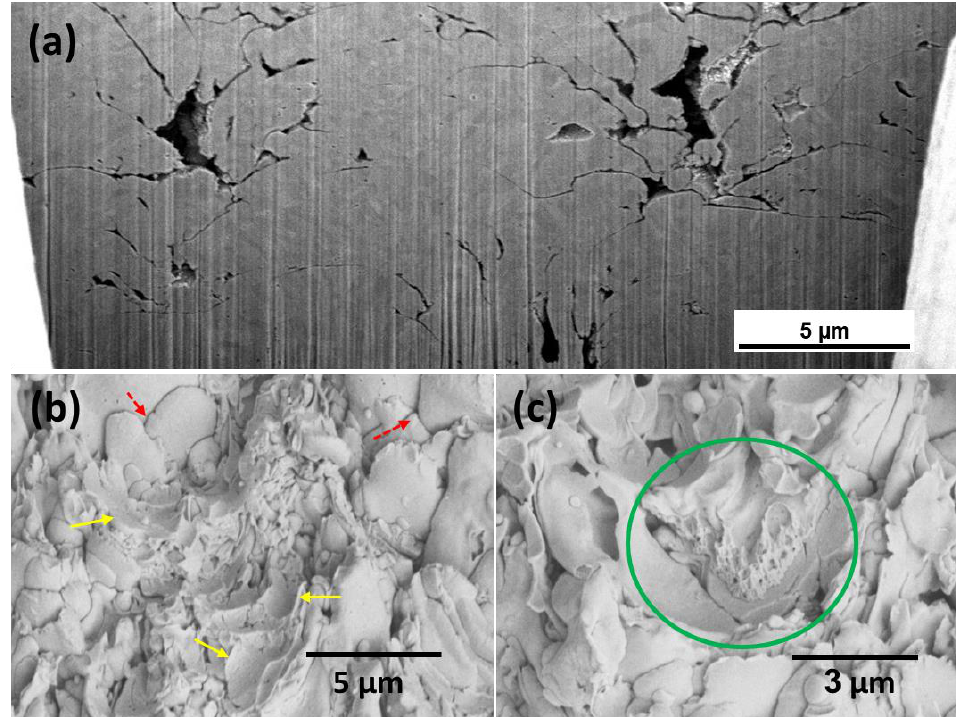
Figure 1. ( a ) SEM cross-section of printed copper structure; ( b , c ) Fractured laser-induced forward transfer (LIFT) copper structure. ( b ) Magnified SEM image that shows piled up flattened droplets (red arrows) and regions of whole droplets separation (yellow arrows). ( c ) Rough, dimple-like surfaces associated with the typical bulk copper fractured surface.